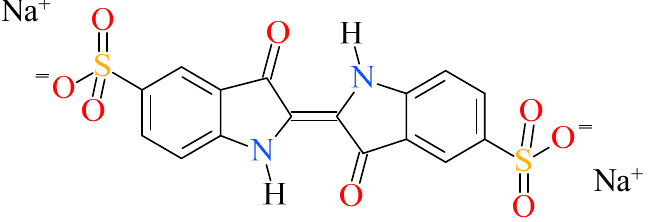
Figure 1. The chemical structure of indigo carmine. IC is an indigoid water-soluble dye used as synthetic food color with maximum per- mitted levels between 50 and 500 mg/kg of food [23]. When its concentration exceeds 500 mg/kg body weight/day, it may become toxic, leading to heart failure and potentially carcinogenic risks [24,25]. IC mineralization by photocatalytic advanced oxidation processes (AOP) using TiO 2 as a photocatalyst was difficult since there was no noticeable loss in the total organic content (TOC) value and release of inorganic ions even if the water coloration disappeared [26]. Recent investigations have shown that MnO 2 could efficiently remove indigo carmine from polluted water by a combined process using both photo and ultrasonic activation and peroxydisulfate (S 2 O 8 − ) as an oxidation agent [27]. It was considered that the catalytic activity of MnO 2 was due to its high affinity for O 2 and its efficient dye adsorption. However, developing AOP using greener oxidants such as hydrogen peroxide would be of higher interest. Therefore, in this work, we have tested the catalytic activity of the synthesized hbnc for the oxidative degradation of IC with H 2 O 2